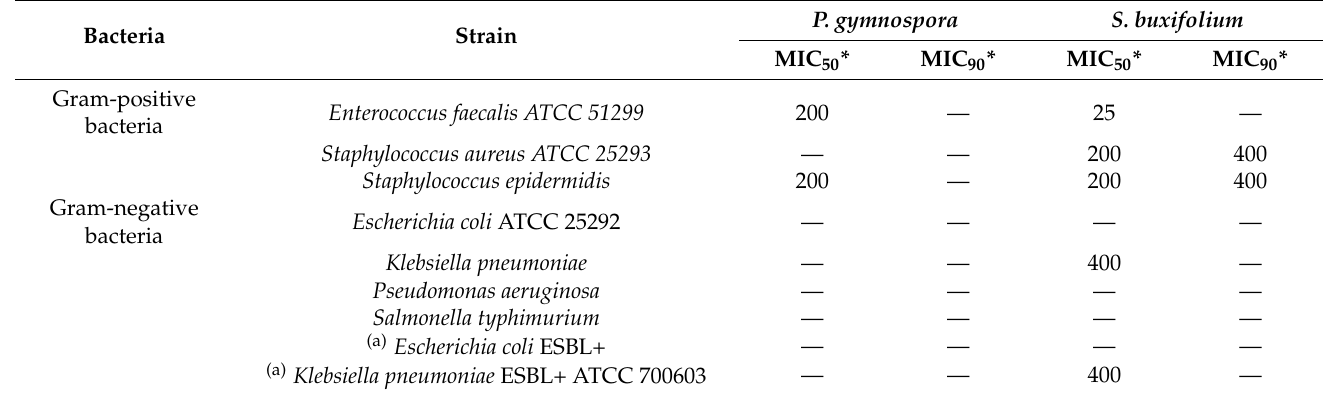
Table 3. Growth-inhibitory activity of algae extracts or compounds against different